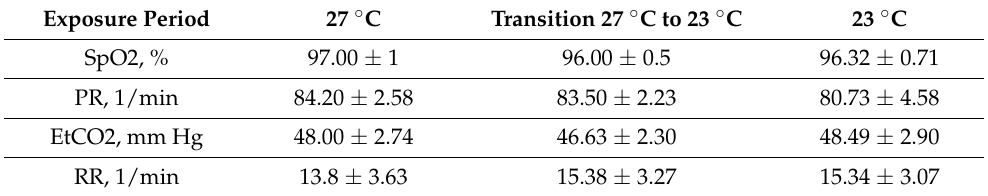
Table 2 summarises the results for physiological parameters of the exposed person for the different periods. Table 2. Results for the physiological measurements in the climate chamber during the different periods. Exposure